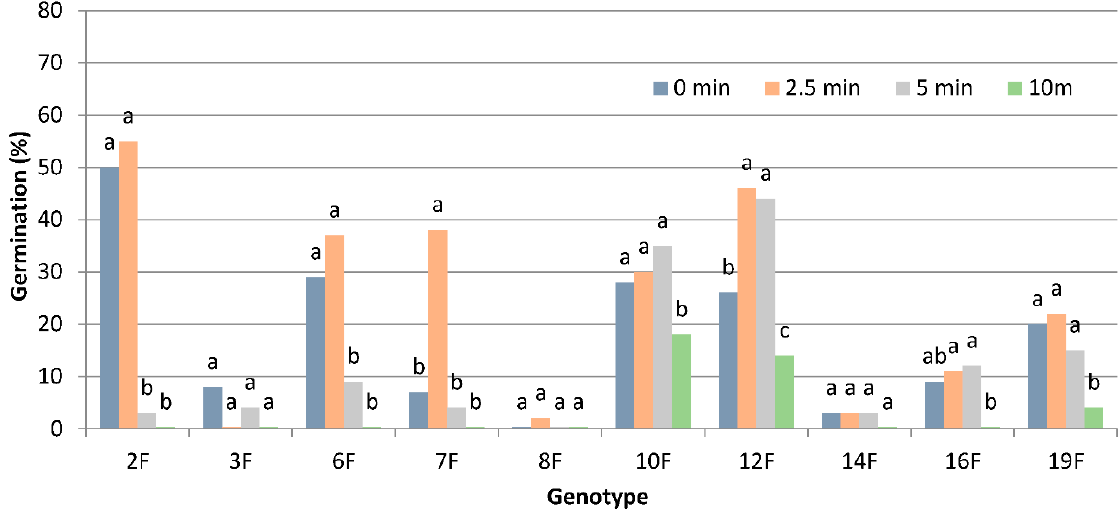
Figure 4. Effect of scarification using H 2 SO 4 , at different time-durations (2.5, 5 or 10 min), on seed germination of ten genotypes of P. lentiscus var. Chia, three weeks from the sowing day. Different letters in each genotype indicate statistically significant differences according to Duncan’s multiple range test at p ≤ 0.05.